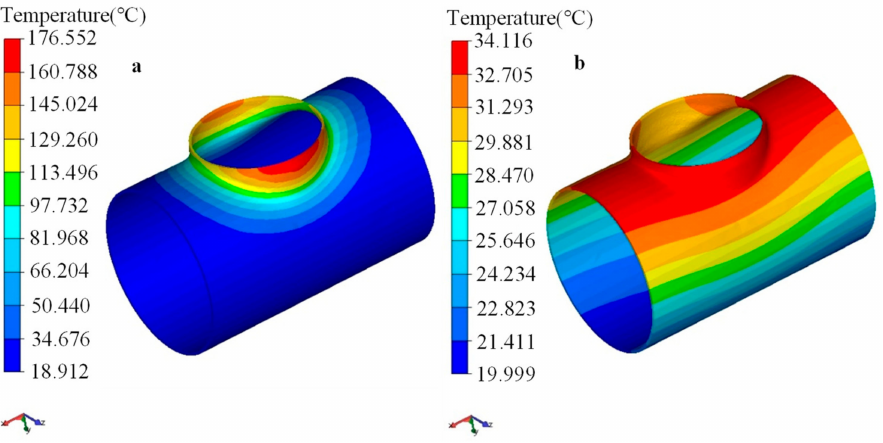
Figure 19. Distribution of temperature during cooling process: ( a ) after flanging, ( b ) 2000 s cooldown. In order to understand the evolution of the temperature in the deformation region during the through process more clearly, four points were selected in the forming area to arrange the virtual sensors according to the heating sequence. The virtual sensors moved with metal flow during the deformation process, as shown in Figure 20a. Figure 20b illustrates the temperature variations recorded by the four virtual sensors during the through process.